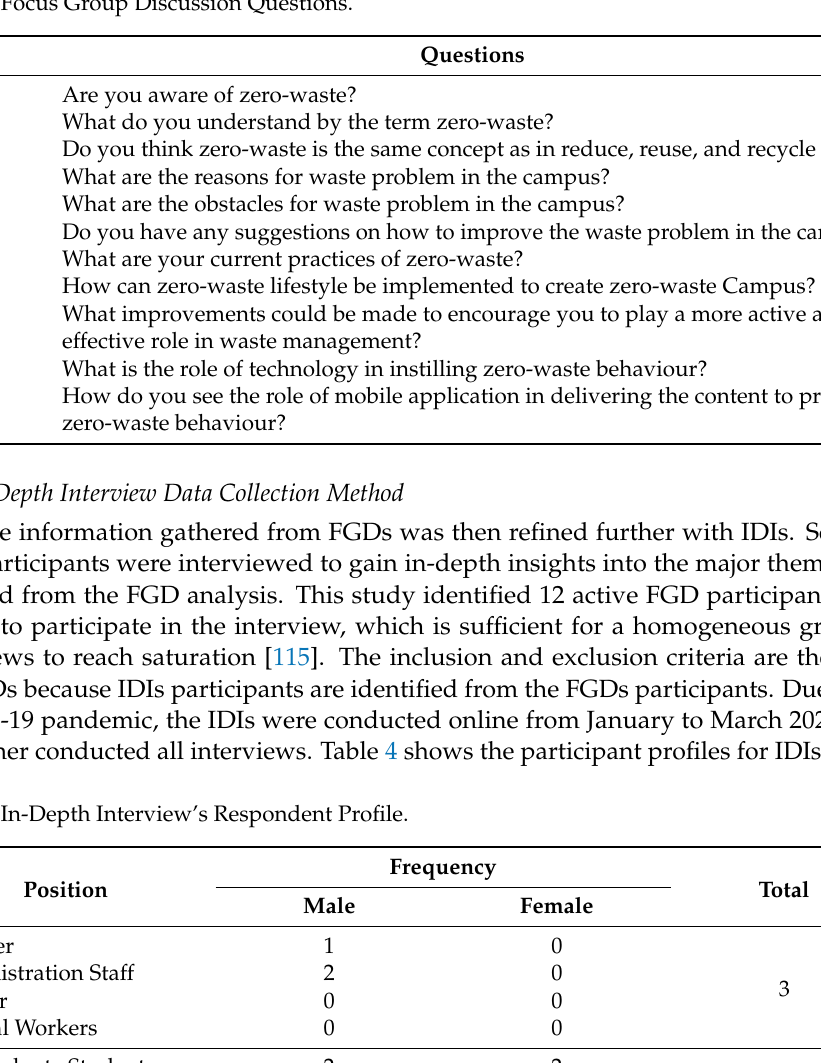
Table 3. Focus Group Discussion Questions.